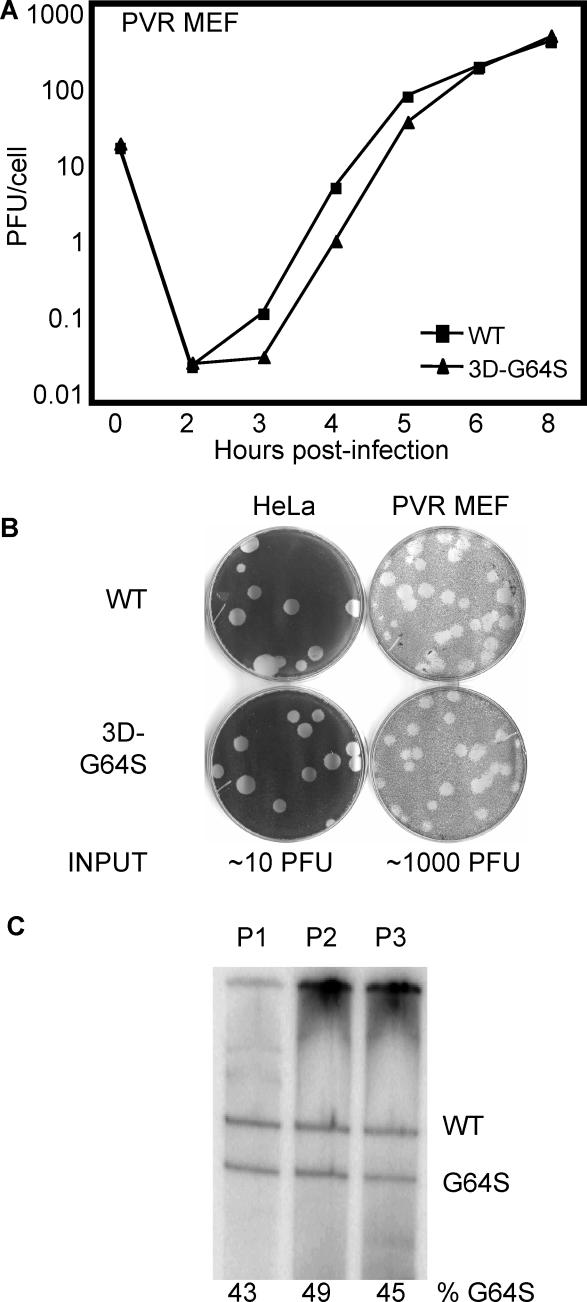
Growth of Wild-Type and 3D-G64S Poliovirus in Primary PVR-MEF(A) Single-cycle growth curve. 2 × 105 PVR-MEF were infected at an MOI of 10 PFU/cell with either wild-type or 3D-G64S viruses at 37 °C. Cell-associated virus was harvested at indicated times and titered by plaque assay.(B) Plaque assays. Wild-type or 3D-G64S poliovirus was plated on HeLa or PVR-MEF monolayers and incubated under an agar overlay for 72 h at 37 °C before staining the cells with crystal violet. The amount of virus plated, according to HeLa titration, is shown underneath as “input.”(C) Serial passage competition assay in PVR-MEF. 3D-G64S and wild-type virus were mixed in a 1:1 ratio and used to infect PVR-MEF at an MOI of 10 PFU/cell at 37 °C. At 6 h post-infection, cell-associated RNA and virus were harvested, and the virus was used to infect fresh cells at high MOI (5–30 PFU/cell). This cycle was repeated a total of three times; BstBI digestion assay products are shown for passages 1, 2, and 3 (P1, P2, P3), and the Phosphorimager-quantified percentage of the G64S product is shown.DOI: 10.1371/journal.ppat.0010011.g004